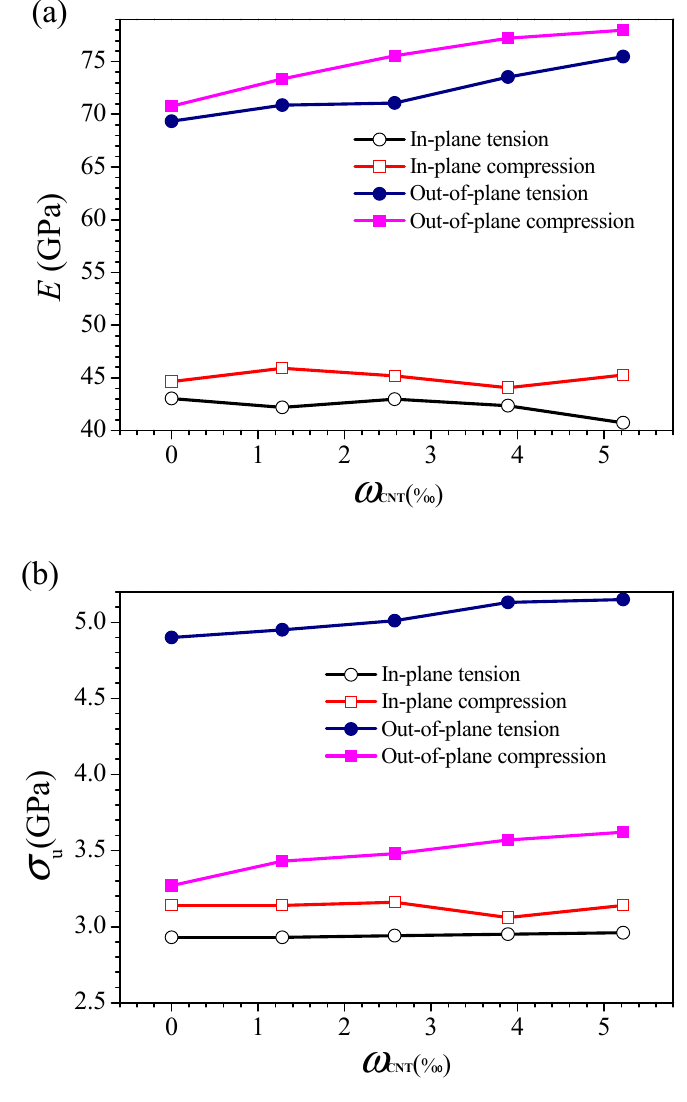
Figure 5. ( a ) Young’s modulus E and ( b ) ultimate strength σ u of CNHONNs with different ω CNT of